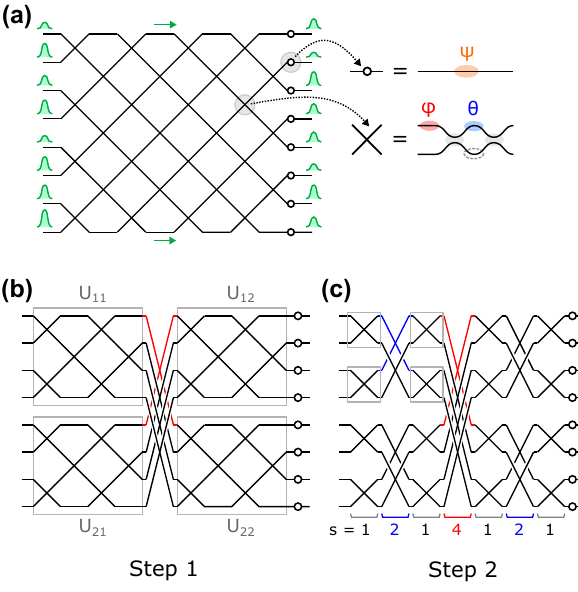
Figure 1: Illustration of optical mesh designs. (a) 8 × 8 Clements mesh. (b) First step of the block decomposition of the mesh. This results in 4 × 4 the SCF